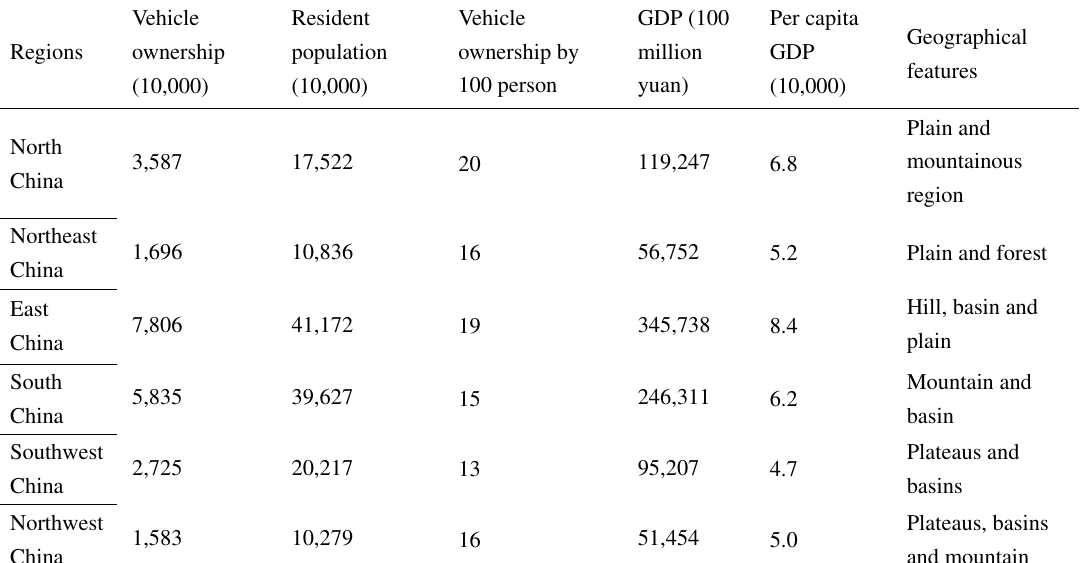
Table 2 The socio-economic status and geographical characteristics of the six major regions